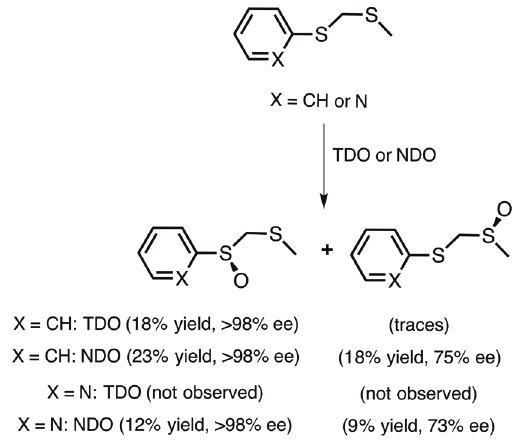
Figure 27 - Sulfoxidation of 1,3-disulfides mediated by TDO and